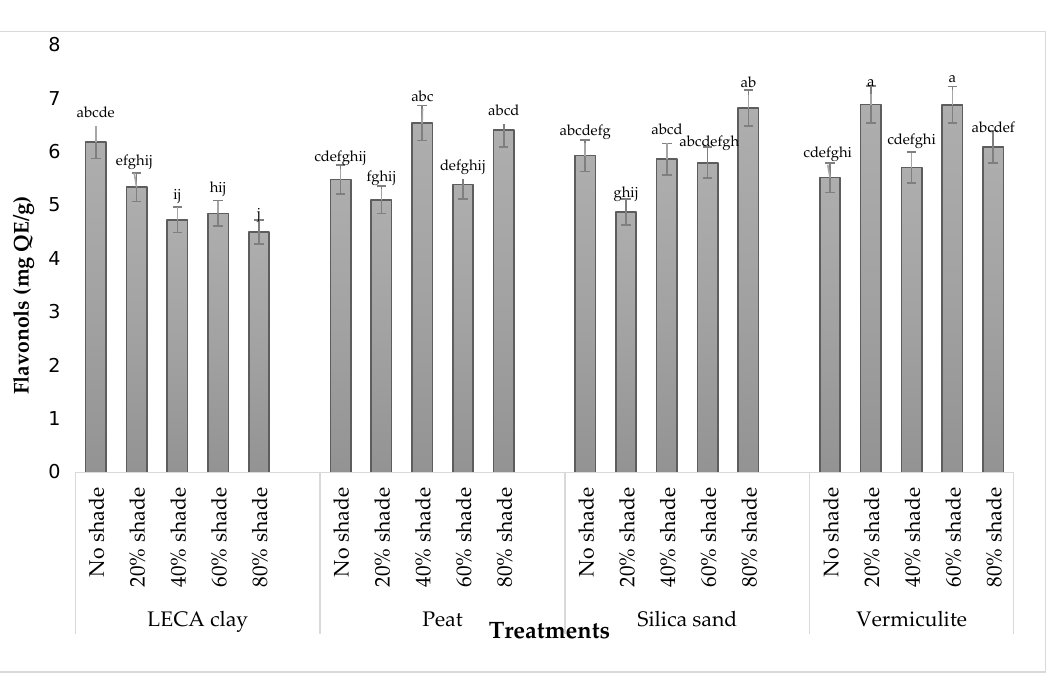
Figure 7. The effect of different growth media and shade levels on total flavonols in the flower buds of T. divaricata . Means followed by the same letter did not differ by Tukey ’ s test ( p > 0.05). The highest DDPH activity in flower buds of T. divaricata was recorded in plants cul- tivated in silica sand under 20% shade, and this was significantly higher than other treat- ments except silica with no shading and LECA clay with 40 and 60% shading. The lowest DPPH activity was recorded in plants treated with 80% shade levels in both LECA clay and vermiculite (Figure 8).